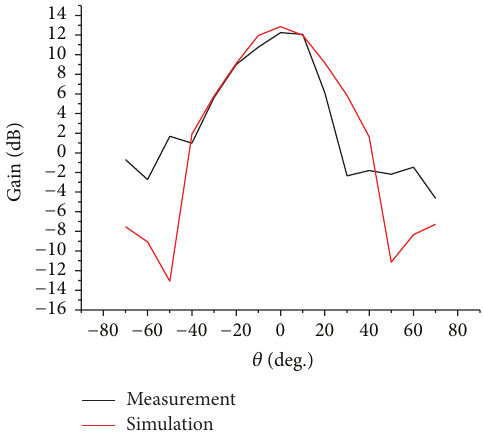
Figure 14: The simulation and measurement of the gain of the antenna ( ℎ = 4𝜆